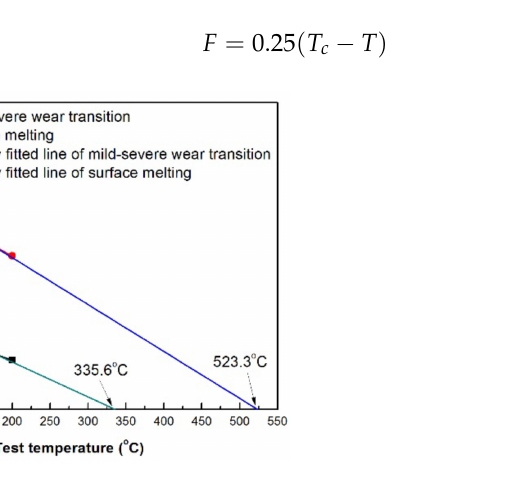
Figure 8. Critical load versus test temperature at mild–severe wear transition and surface melt- ing